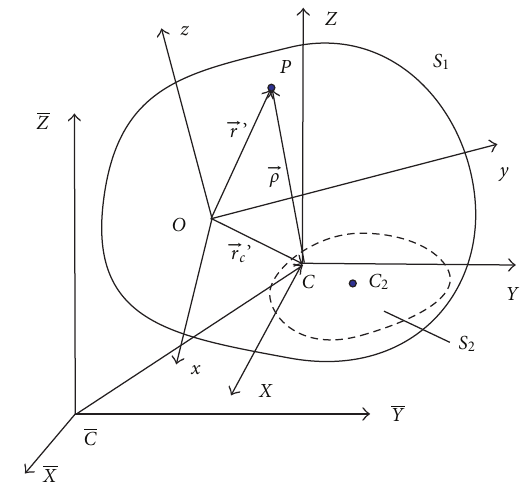
Figure 3: Coordinate frames.